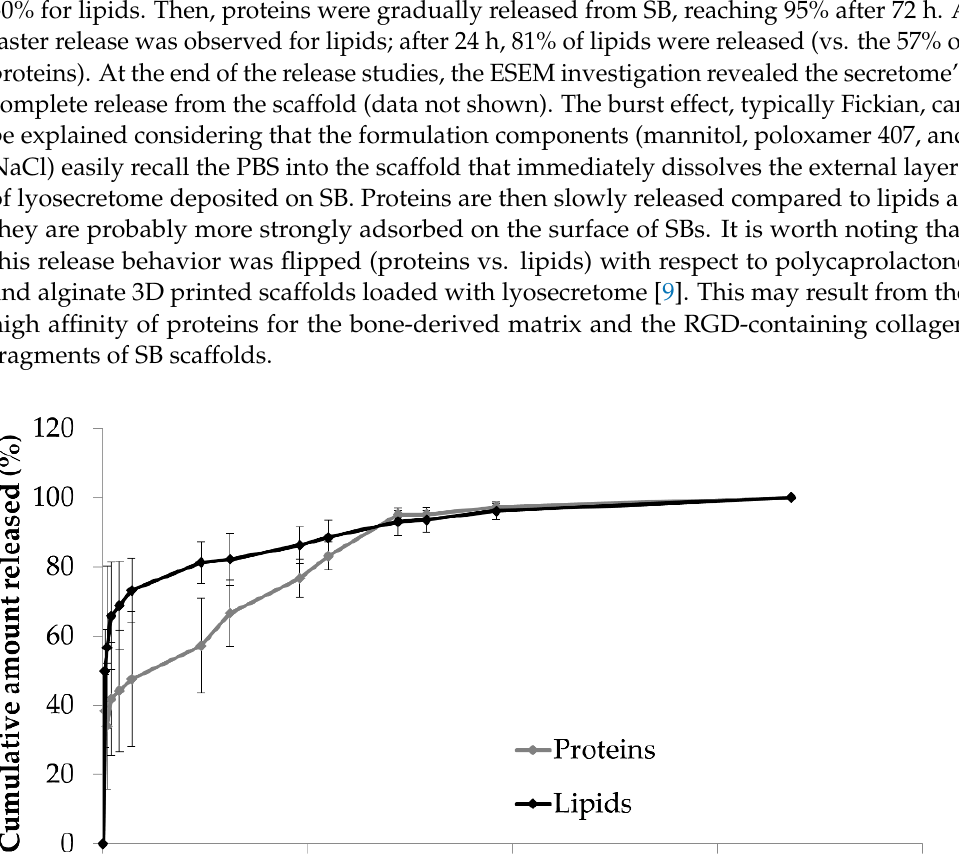
Table 1. Results of in vitro release model fitting for proteins and lipids from SBlyo. Kinetic elaborations were performed on release data obtained from at least three independent experiments for each batch. “~” indicates that the analysis performed was “ambiguous”; therefore, the fit does not nail down the values of all the parameters, and 95% confidence bounds cannot be reported. These latter data were not considered in the interpretation of results.